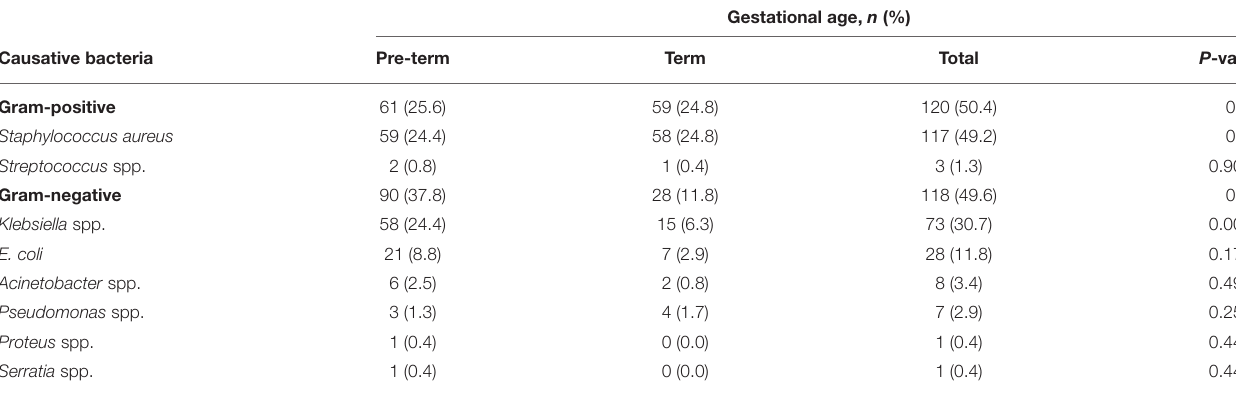
TABLE 6 | Distribution of microorganisms according to gestational age